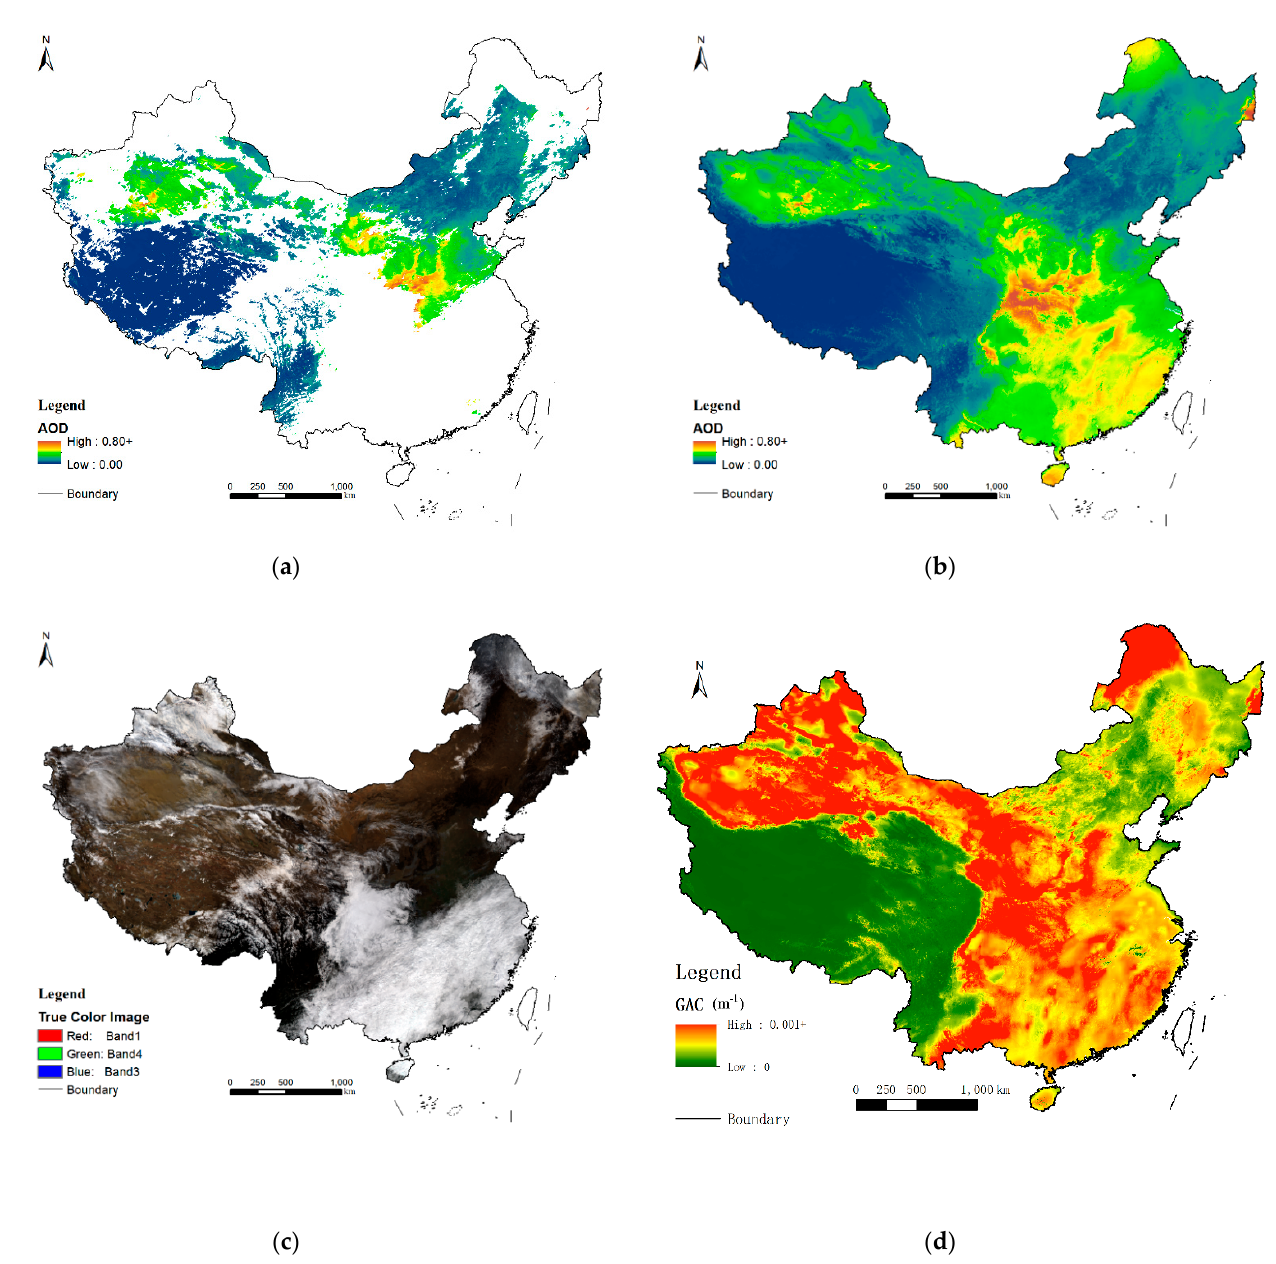
Figure 12. Imputation of MAIAC AOD for a winter day (30 December) of 2018: original AOD ( a ), complete AOD ( b ), MAIAC ground reflectance of true color ( c ) and GAC ( d ).